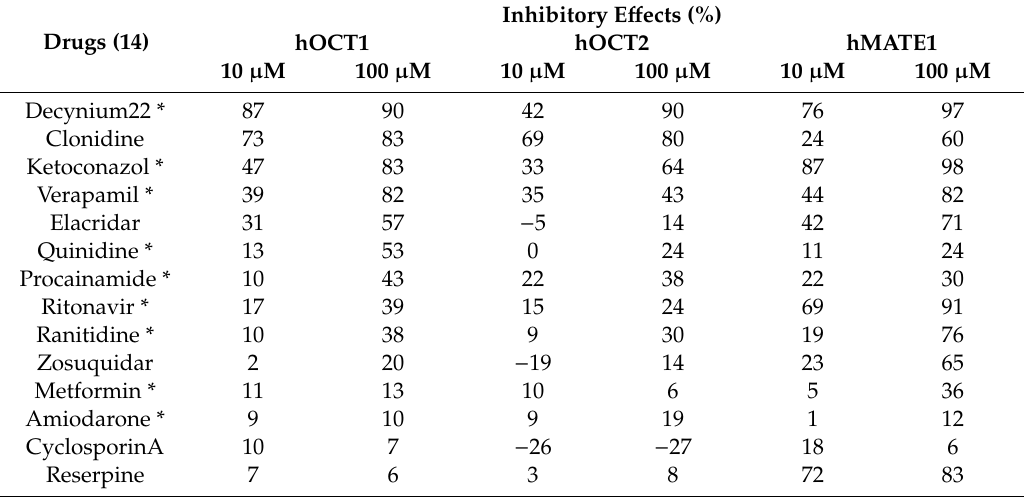
Table 3. Inhibitory e ff ects of various cationic drugs to hOCT1- and hOCT2-mediated 3 H-MPP uptake and MATE1-mediated 14 C-metformin uptake.